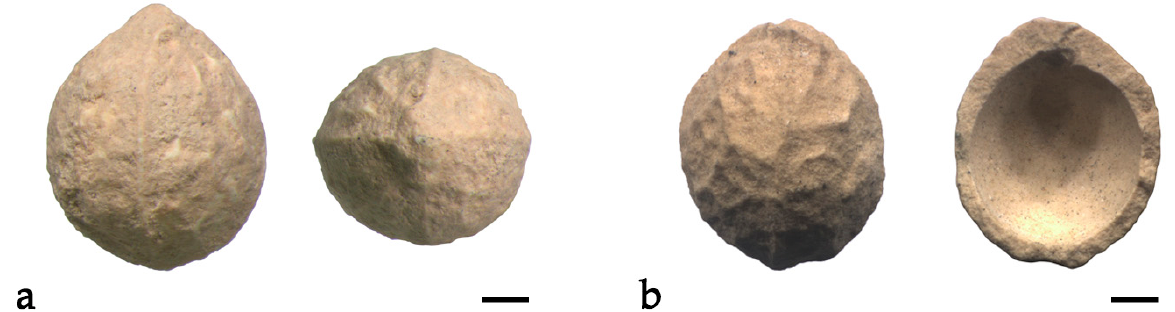
Figure 9. Celtis endocarps from Abrigo de la Quebrada ( a ) and Cueva del Arco ( b ) (scale bar: 1 mm). Table 6. Radiocarbon dating results of Celtis endocarps.